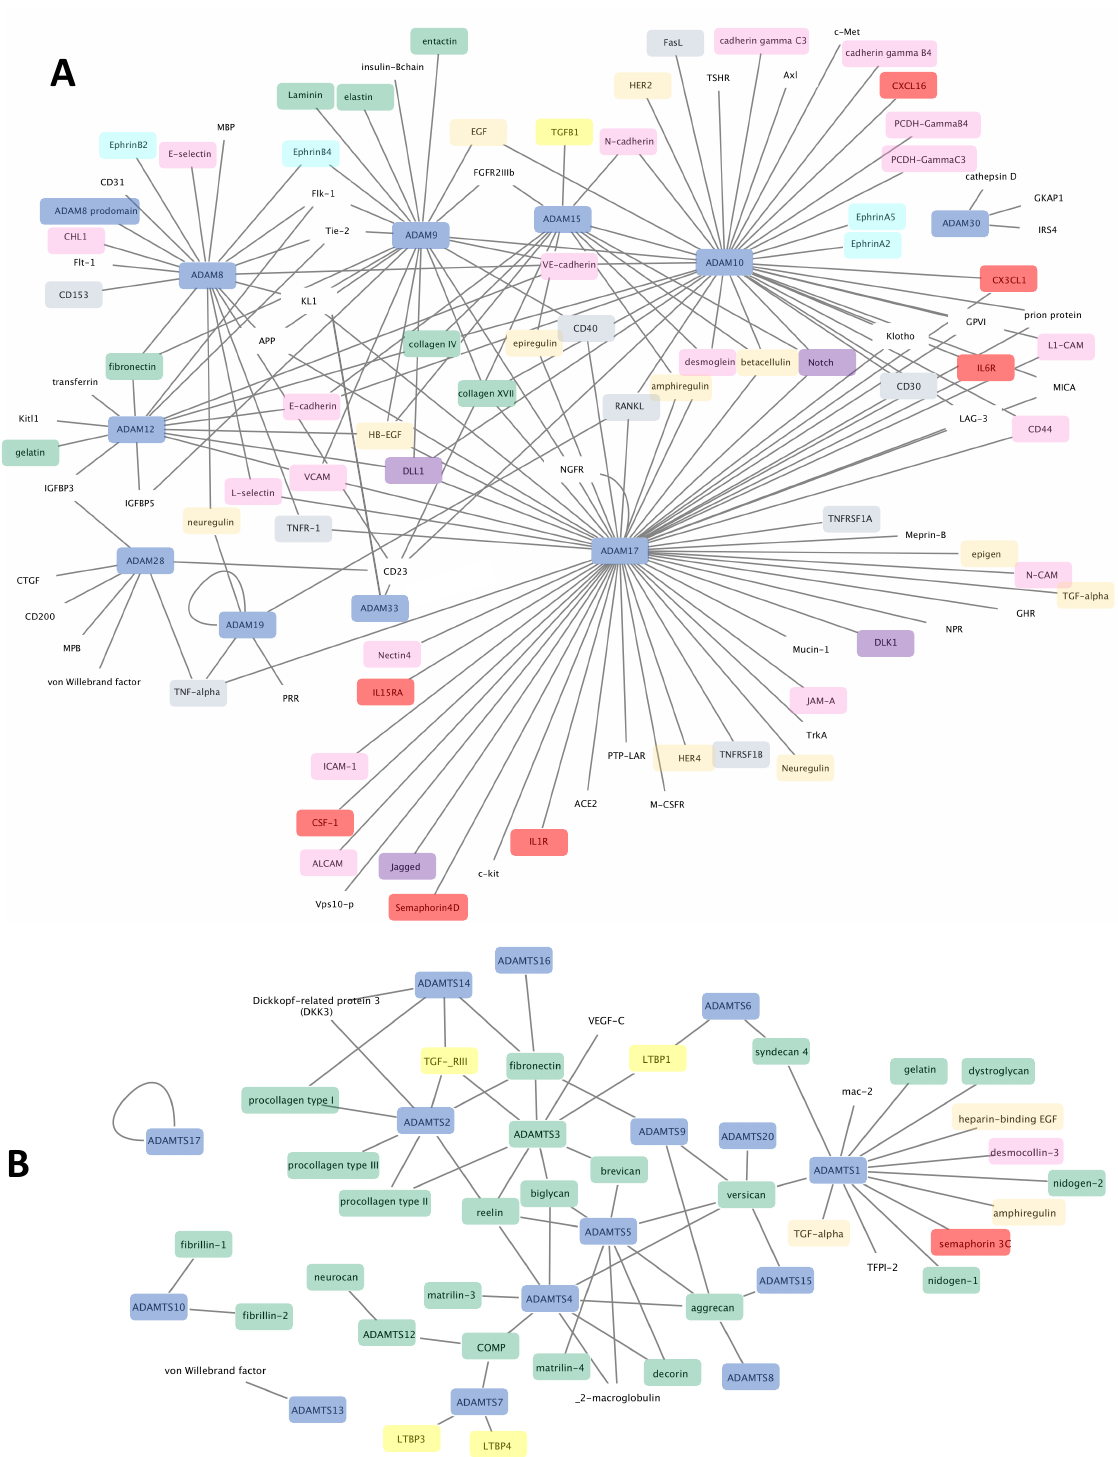
Figure 2. Substrates networks for ADAM ( A ) and ADAMTS ( B ). Generated from data reported in [5,17] and plotted using cy- toscape software platform (https://cytoscape.org/, accessed on 14 January 2021). Colors of nodes: blue, ADAM/ADAMTS; green, extracellular matrix components; red, cytokine/chemokine; pink, adhesion/junction molecules; grey, TNF superfam- ily components; purple, Notch signaling components; yellow, TGF- β signaling components; turquoise, ephrin signaling components. The remaining uncolored nodes correspond to miscellaneous